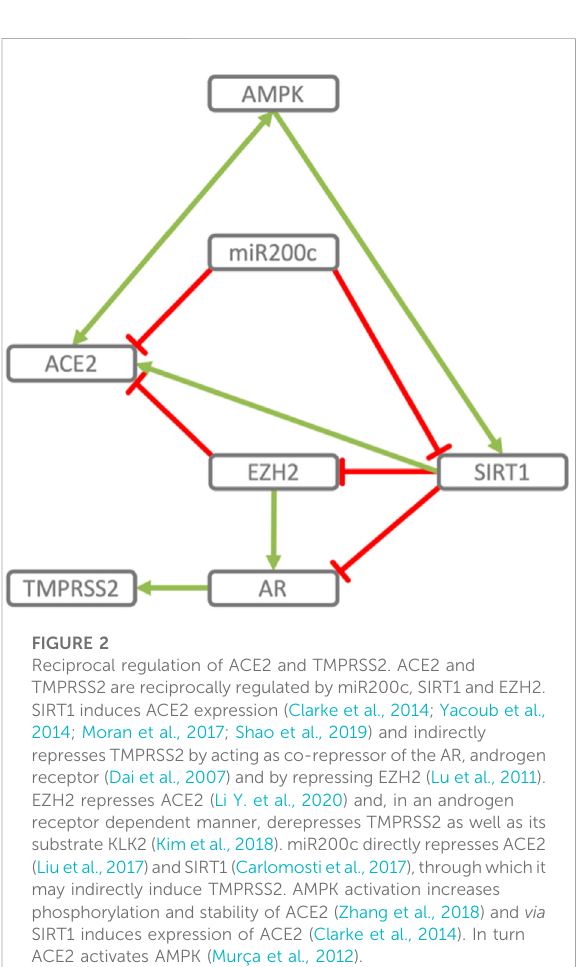
FIGURE 2 Reciprocal regulation of ACE2 and TMPRSS2. ACE2 and TMPRSS2 are reciprocally regulated by miR200c, SIRT1 and EZH2. SIRT1 induces ACE2 expression (Clarke et al., 2014; Yacoub et al., 2014; Moran et al., 2017; Shao et al., 2019) and indirectly represses TMPRSS2 by acting as co-repressor of the AR, androgen receptor (Dai et al., 2007) and by repressing EZH2 (Lu et al., 2011). EZH2 represses ACE2 (Li Y. et al., 2020) and, in an androgen receptor dependent manner, derepresses TMPRSS2 as well as its substrate KLK2 (Kim et al., 2018). miR200c directly represses ACE2 (Liuetal.,2017)andSIRT1(Carlomostietal.,2017),throughwhichit may indirectly induce TMPRSS2. AMPK activation increases phosphorylation and stability of ACE2 (Zhang et al., 2018) and via SIRT1 induces expression of ACE2 (Clarke et al., 2014). In turn ACE2 activates AMPK (Murça et al.,